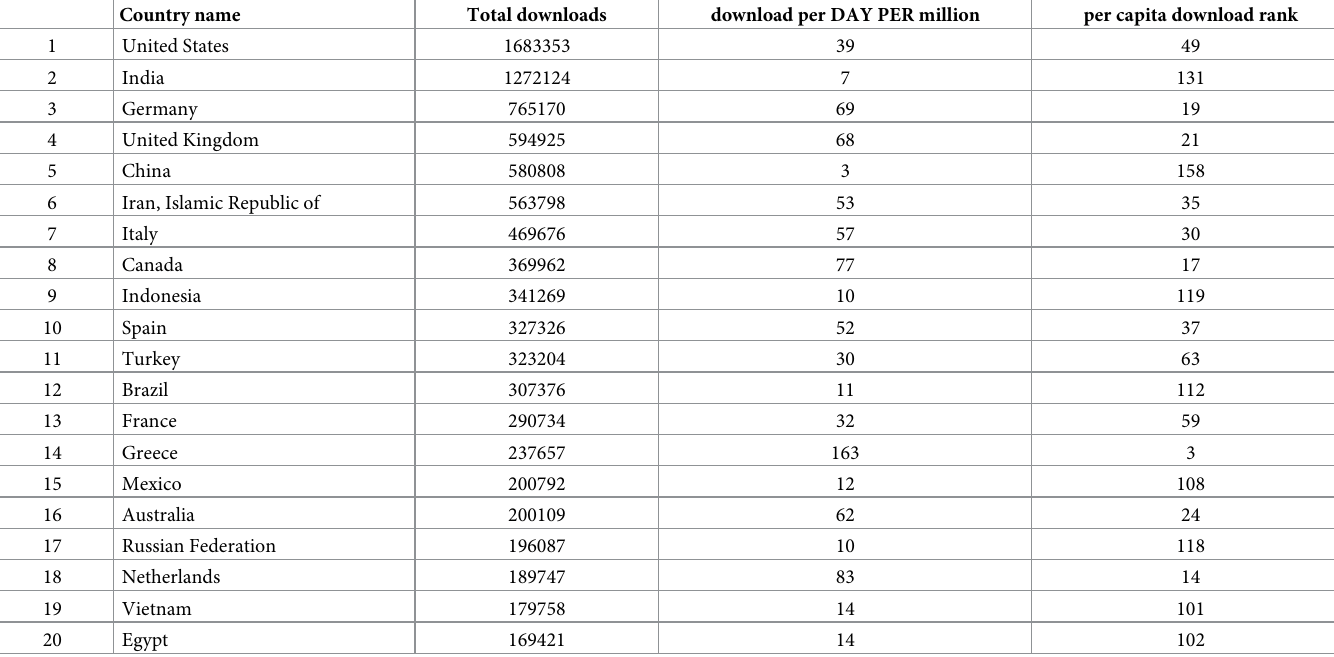
Table 1. Country level statistics for the first 20 countries by aggregate download